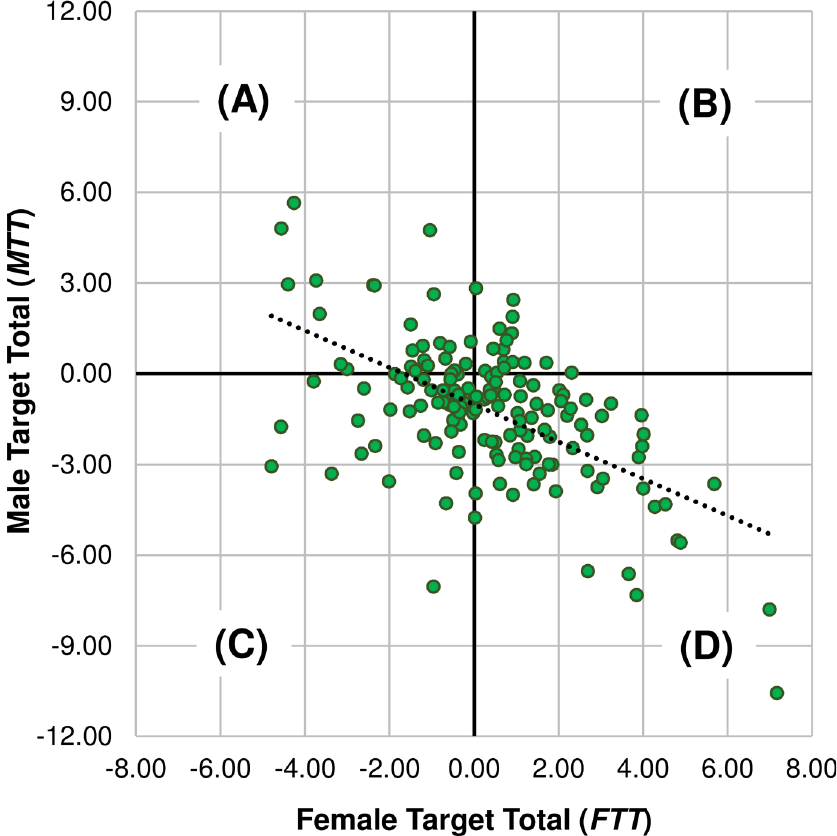
Fig 3. Relationship between two bias totals of 160 hand observers. Observer demographics and statistics are described in the main text. Negative values on either axis represent a tendency to report a target sex as present; positive values indicate a tendency toward reporting target sex as absent. Total bias score from female target conditions ( FTT ) correlated negatively with the score summed from male target conditions ( MTT ) as indicated by the dotted line of best fit. Ignoring differences between conditions or groups ( A ) 16% of observers shared a tendency to report the presence of females and absence of males overall; ( B ) 28% tended to report both the absence of females and males; ( C ) 10% had a tendency to report the presence of females and males and; ( D ) 46% tended toward reporting males as present but females as absent. One data point (x-y coordinates: 7.16, -10.55) is truncated here to preserve